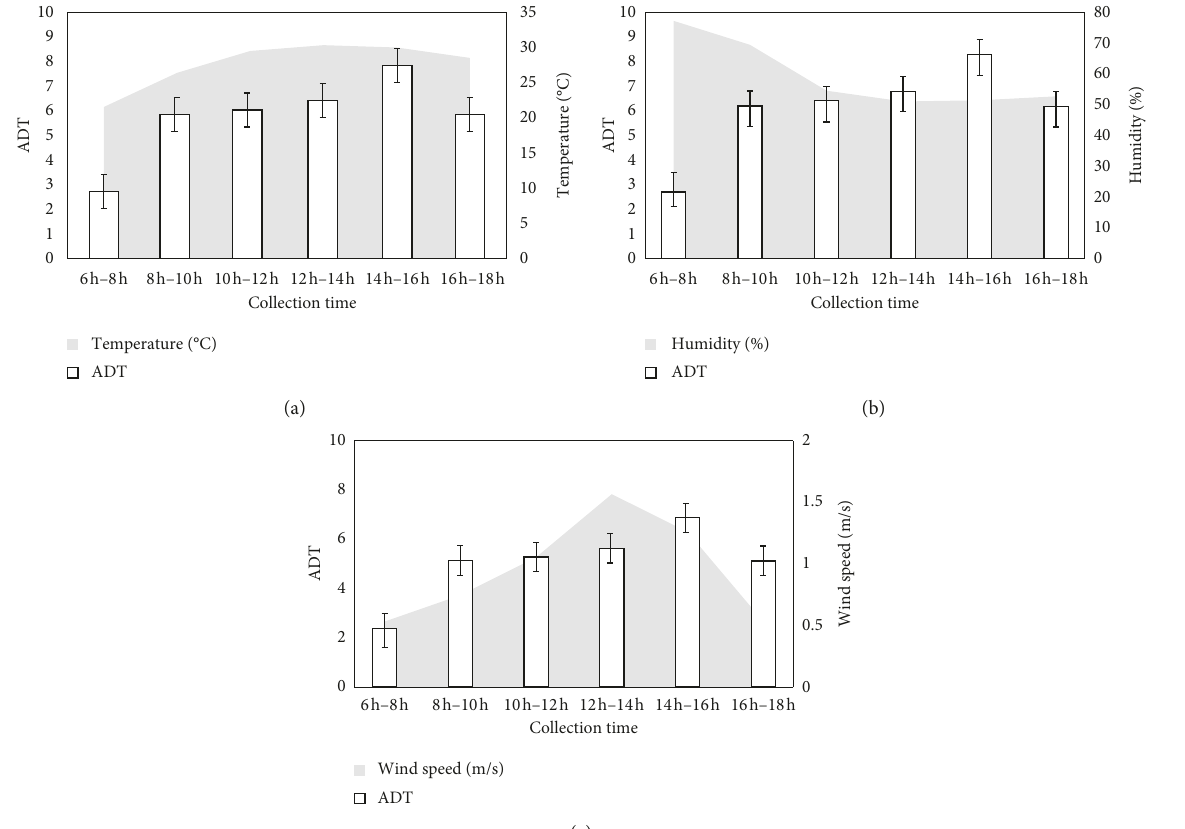
Figure 5: Association of daily activity rhythms with weather variables: (a) temperature; (b) humidity; (c) wind speed. ADT: trap apparent density.